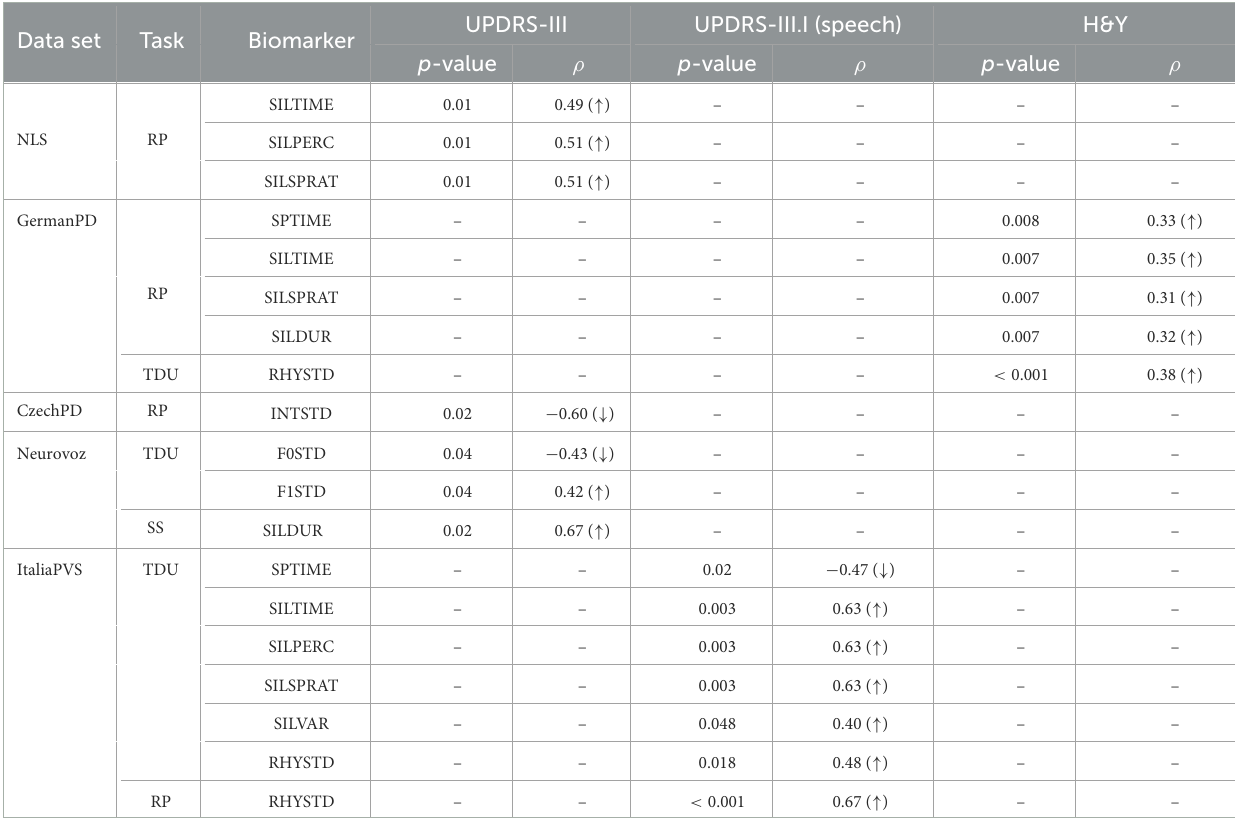
TABLE 7 Results of Spearman’s rank correlation ( ρ ) with corresponding p -values after the FDR correction.